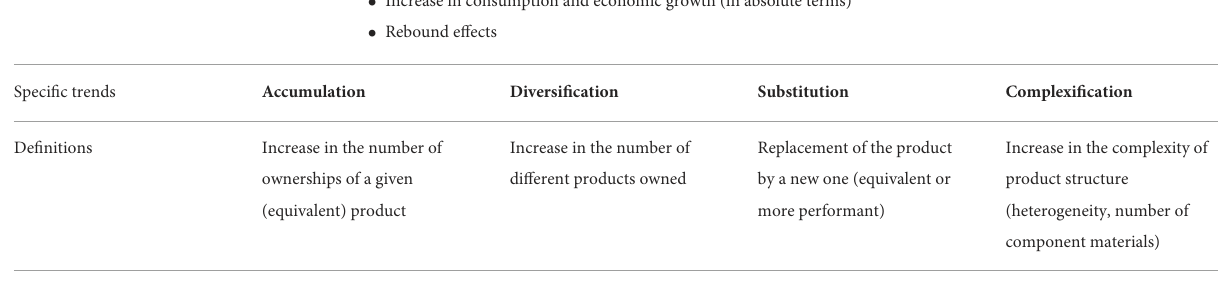
TABLE 2 Links between technological innovation and economy/consumption.